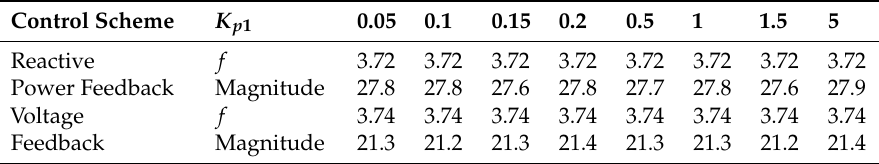
Table 1. The oscillation frequency and its magnitude with the ranging of K p 1 .